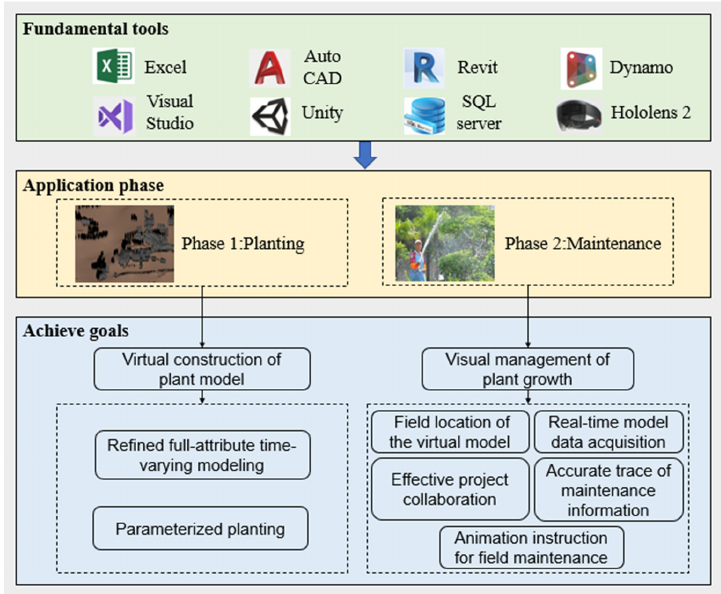
Figure 1. A framework for intelligent construction and management of landscapes.